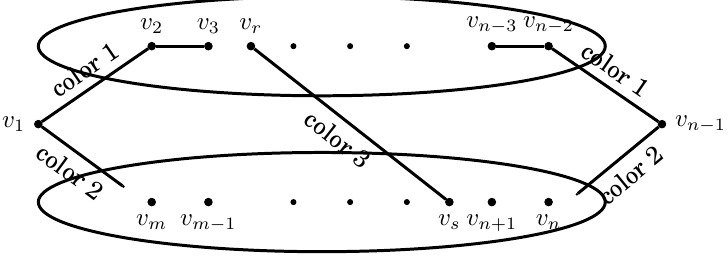
Figure 2: Subcase 2.1 of the proof of Theorem